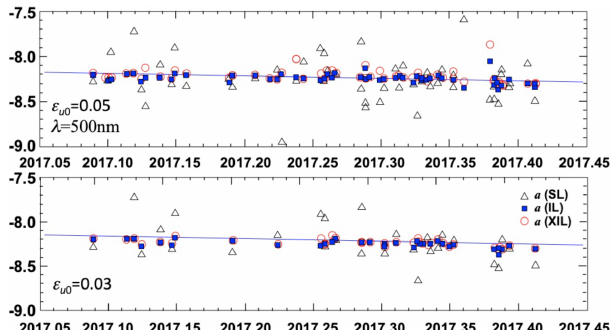
Figure 6. Time series of estimated a values by IL and XIL methods for ILP data at the Tokyo University of Science (TUS) site for 4 months from February through May 2017. Presented are the results of two screening conditions of Eq. (17) with ε u 0 = 0 . 05 and 0.03 at λ = 500nm.